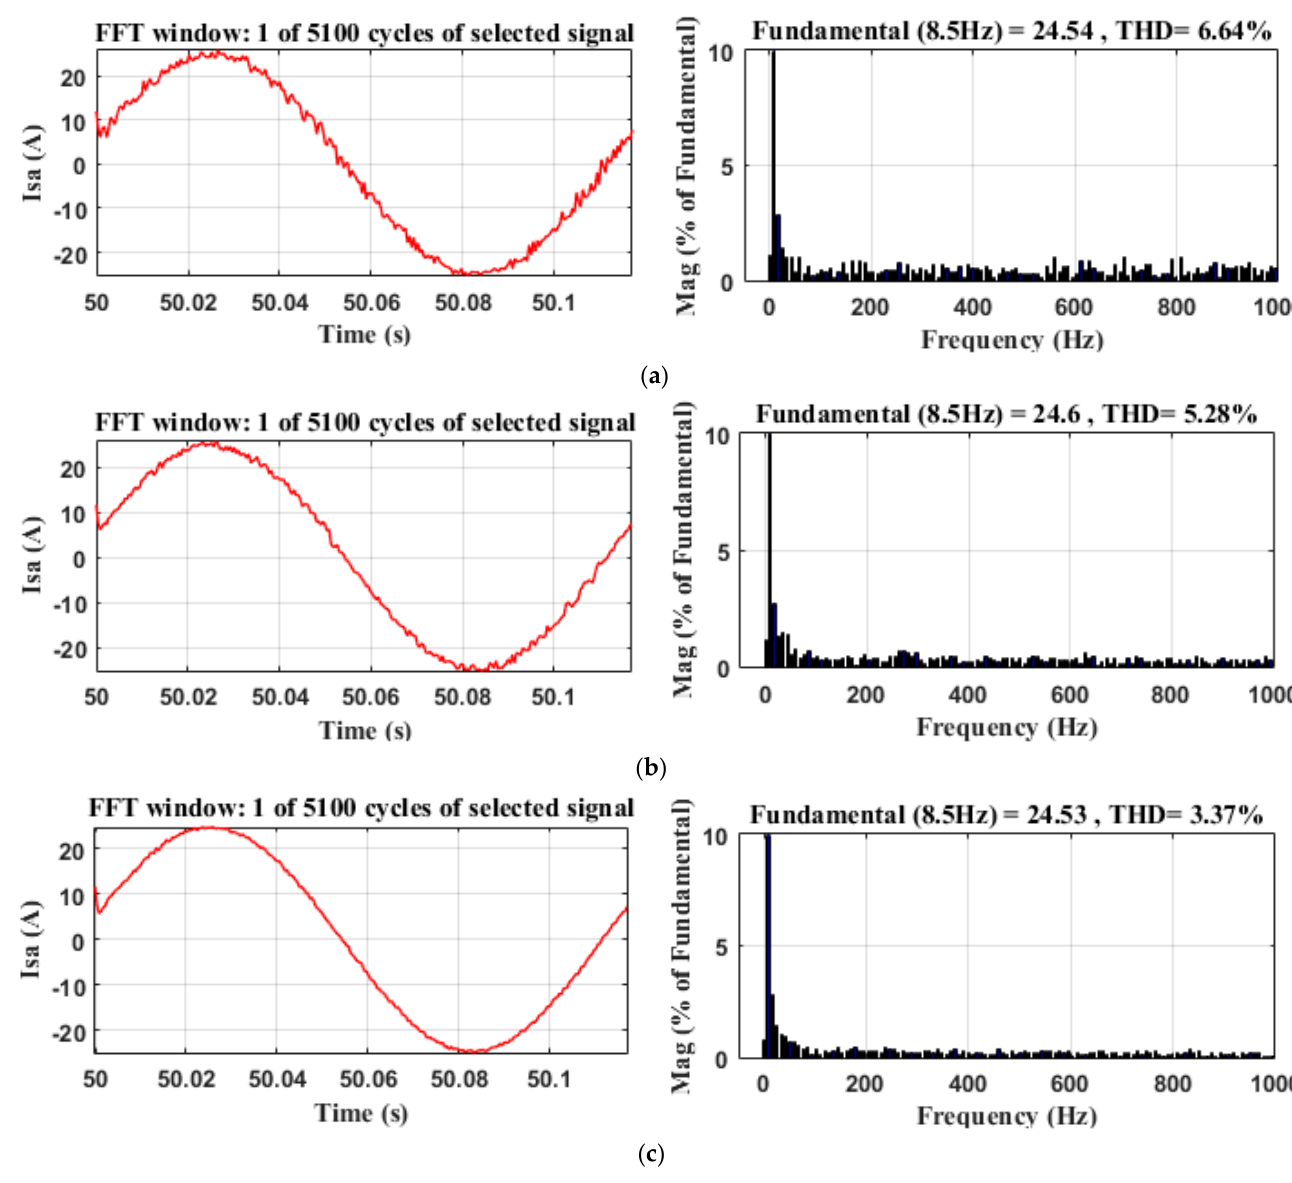
Figure 20. FFT analyses of phase current with different techniques ( a ) DTC; ( b ) FDTC; ( c ) MPDTC. Table 7. Performances of the different control techniques in terms of torque ripples, flux ripples, speed ripples and